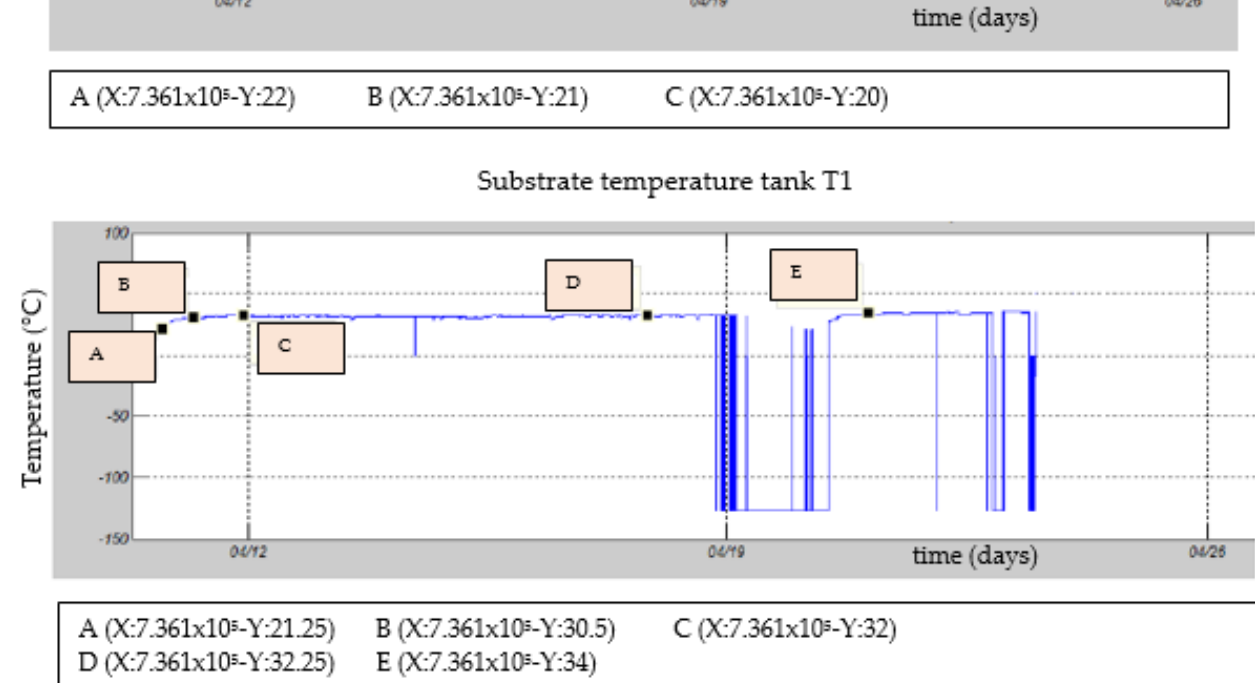
Figure 10. Temperature data in the center of the substrate in both tanks [9].